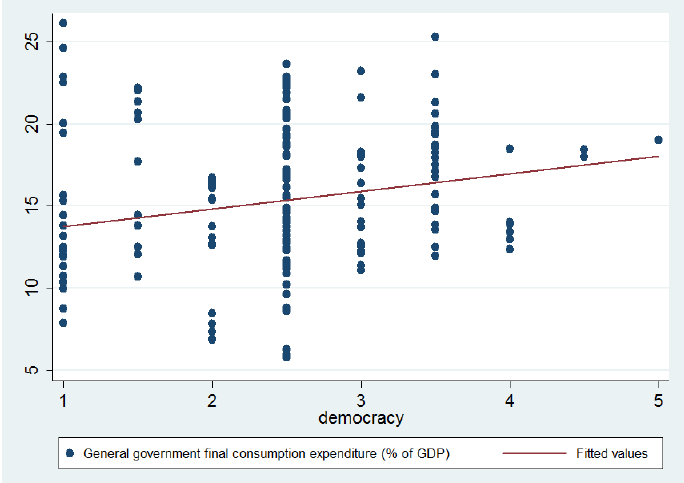
Figure 4: Democracy and public consumption expenditure in the Arab